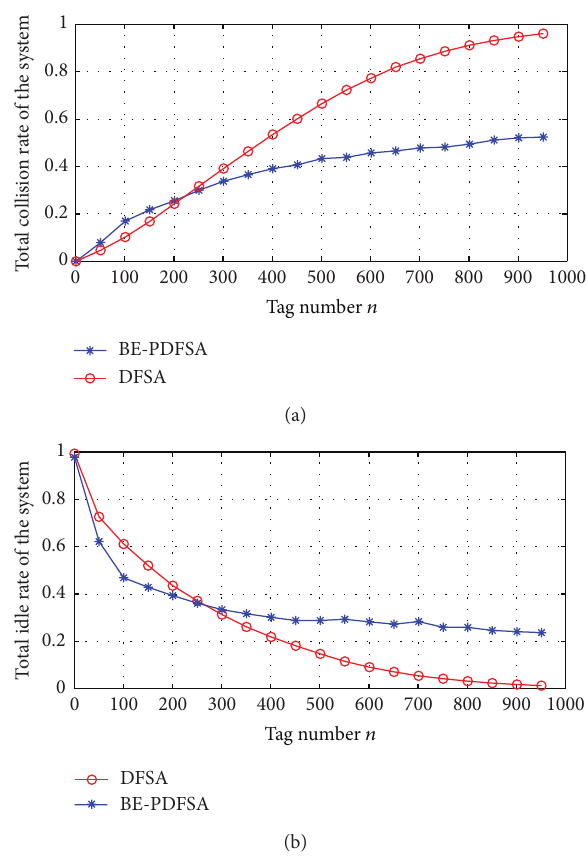
Figure 6: (a) Comparison of collision rate for algorithms in identification process. (b) Comparison of idle rate for algorithms in identification